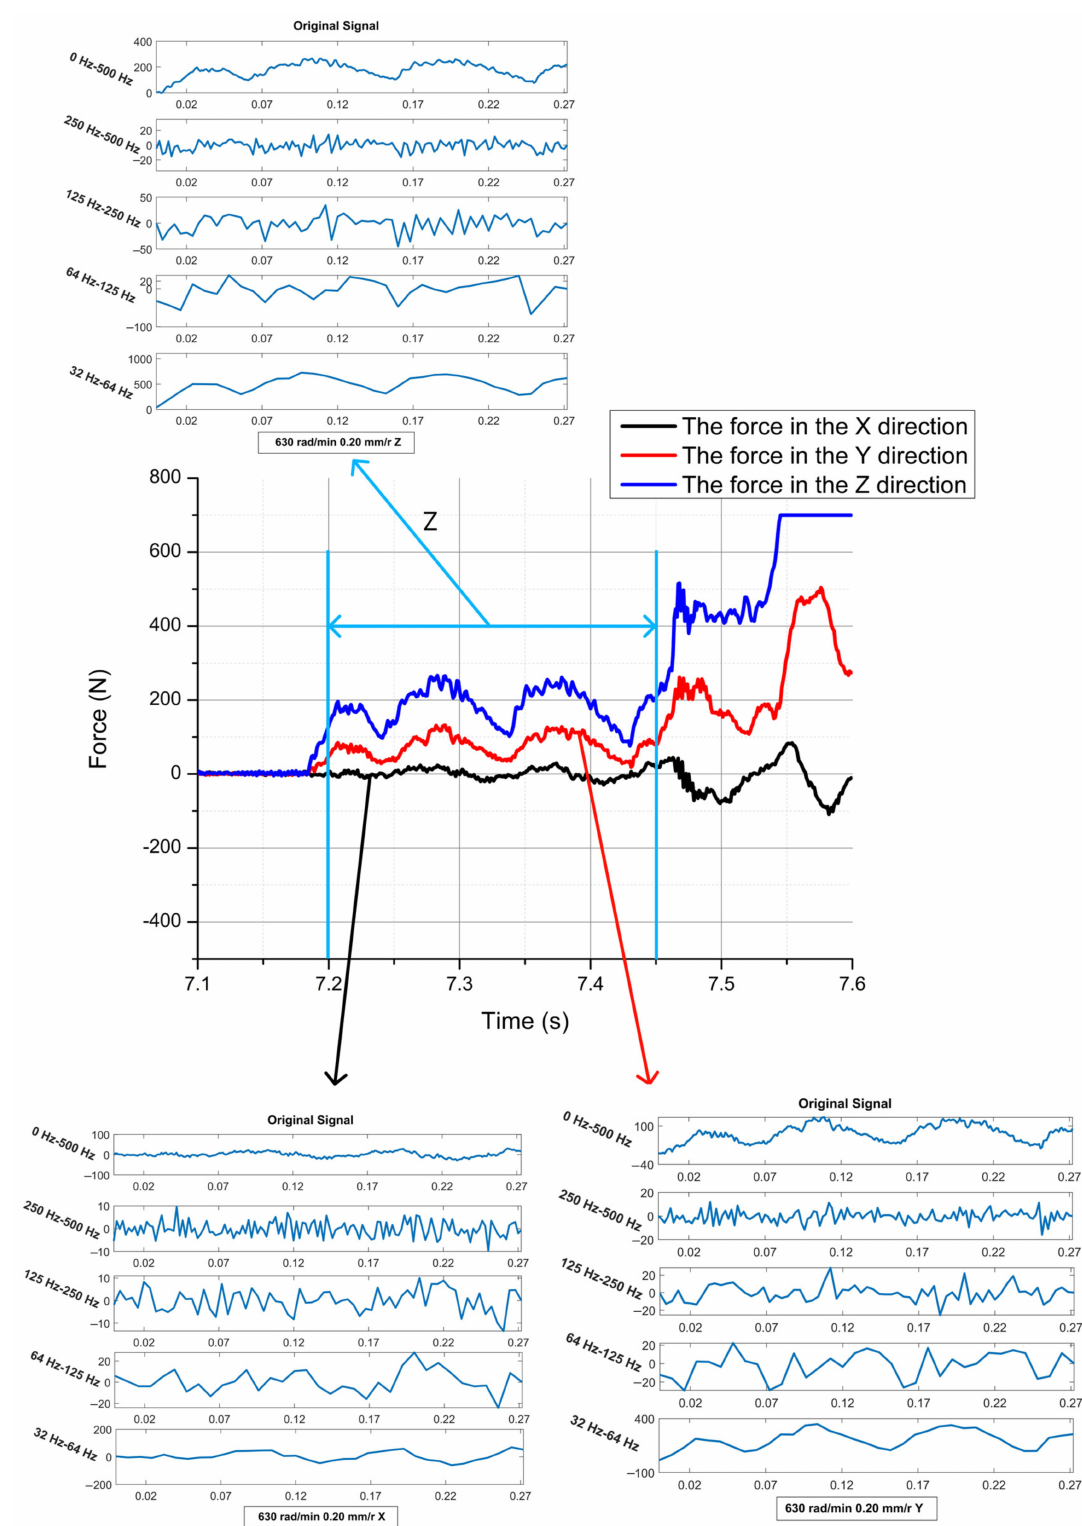
Figure 13. Forces in three directions at a rotational speed of 630 rad/min and feed rate of 0.20